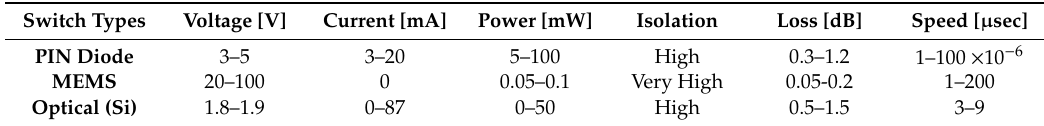
Table 2. Properties for various switches [75–80].